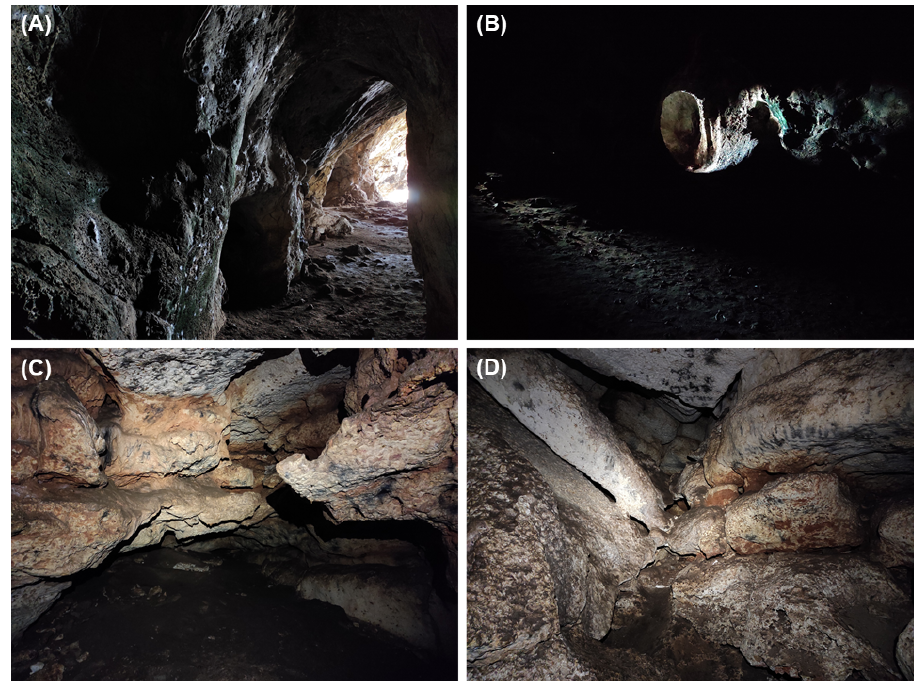
Figure 2. Examples of the distinct ecological zones of a cave (Ornit cave in the Karmel mountain ridge): ( A ) The cave entrance visible from the twilight zone chamber. ( B ) The twilight zone visible from the back of the twilight zone chamber. ( C , D ) Example photographs of the dark zone taken with flash. Photos taken by Shlomi Aharon.